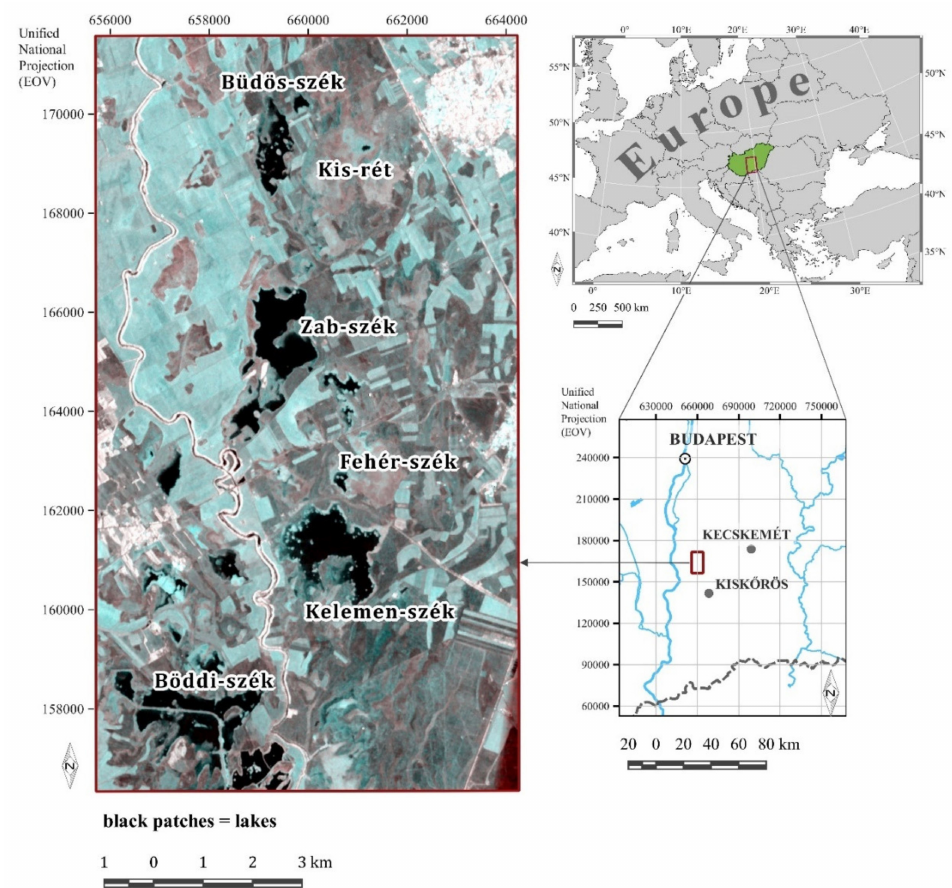
Figure 1. The study area was the Upper-Kiskuns á g Alkaline Lakes (lake is called “sz é k” in regional Hungarian) (background image: Sentinel-1 2014–2018 composite; RGB: VH / VV /